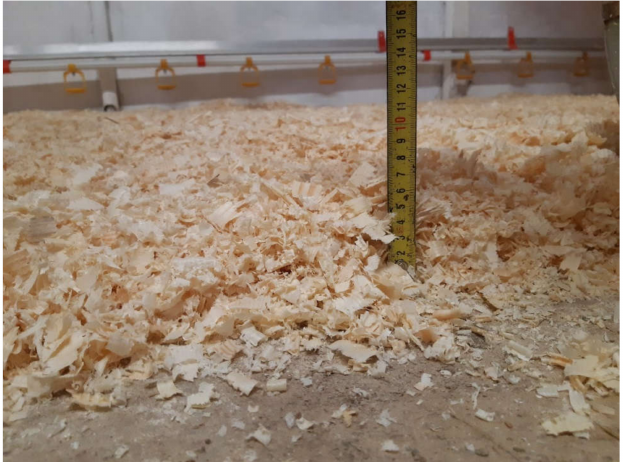
Figure 1. The set of wood shavings at the start of the experiment (photo: own